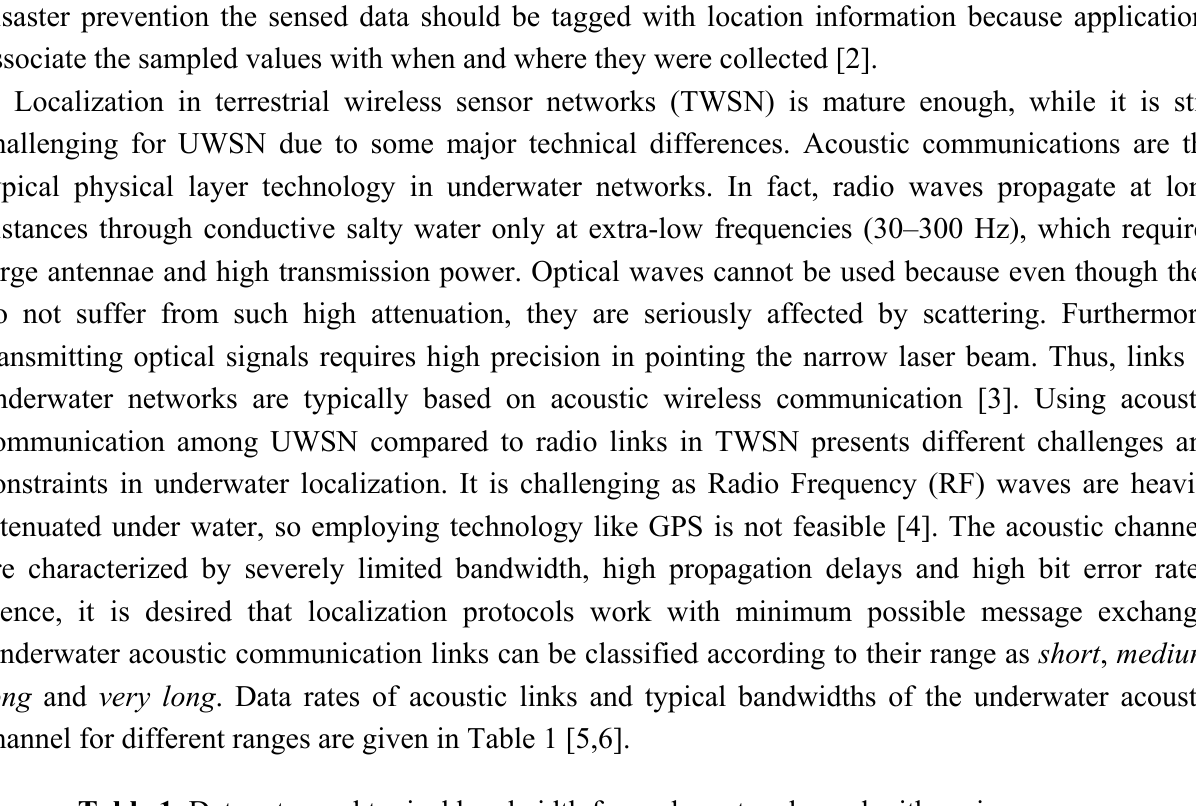
Table 1. Data rates and typical bandwidth for underwater channel with various